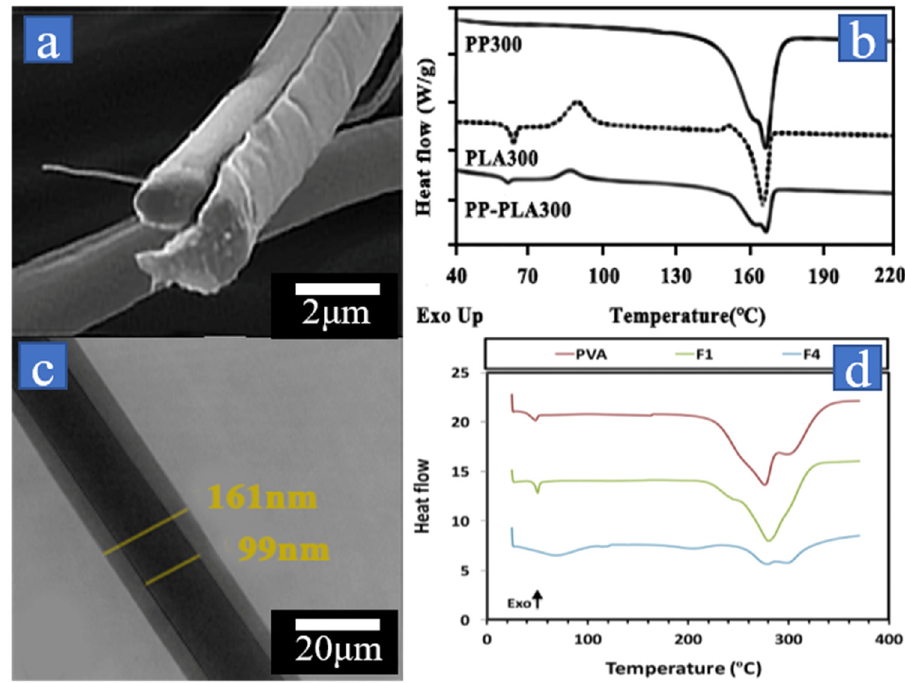
Figure 13: ( a ) SEM image of the cross section of a PP/PLA S/S fi lament ( PP - PLA300 ) , ( b ) DSC thermograph of PP, PLA monocomponent, and PP/PLA bicomponent melt - blown. ( c ) TEM images of electrospun nano fi bers, ( d ) DSC thermograph of electrospun nano fi bers. ( a and b ) Adapted with permission ( 134 ) Copyright 2016, Wiley Periodicals; ( c and d ) adapted with permission ( 135 ) Copyright 2019, Elsevier